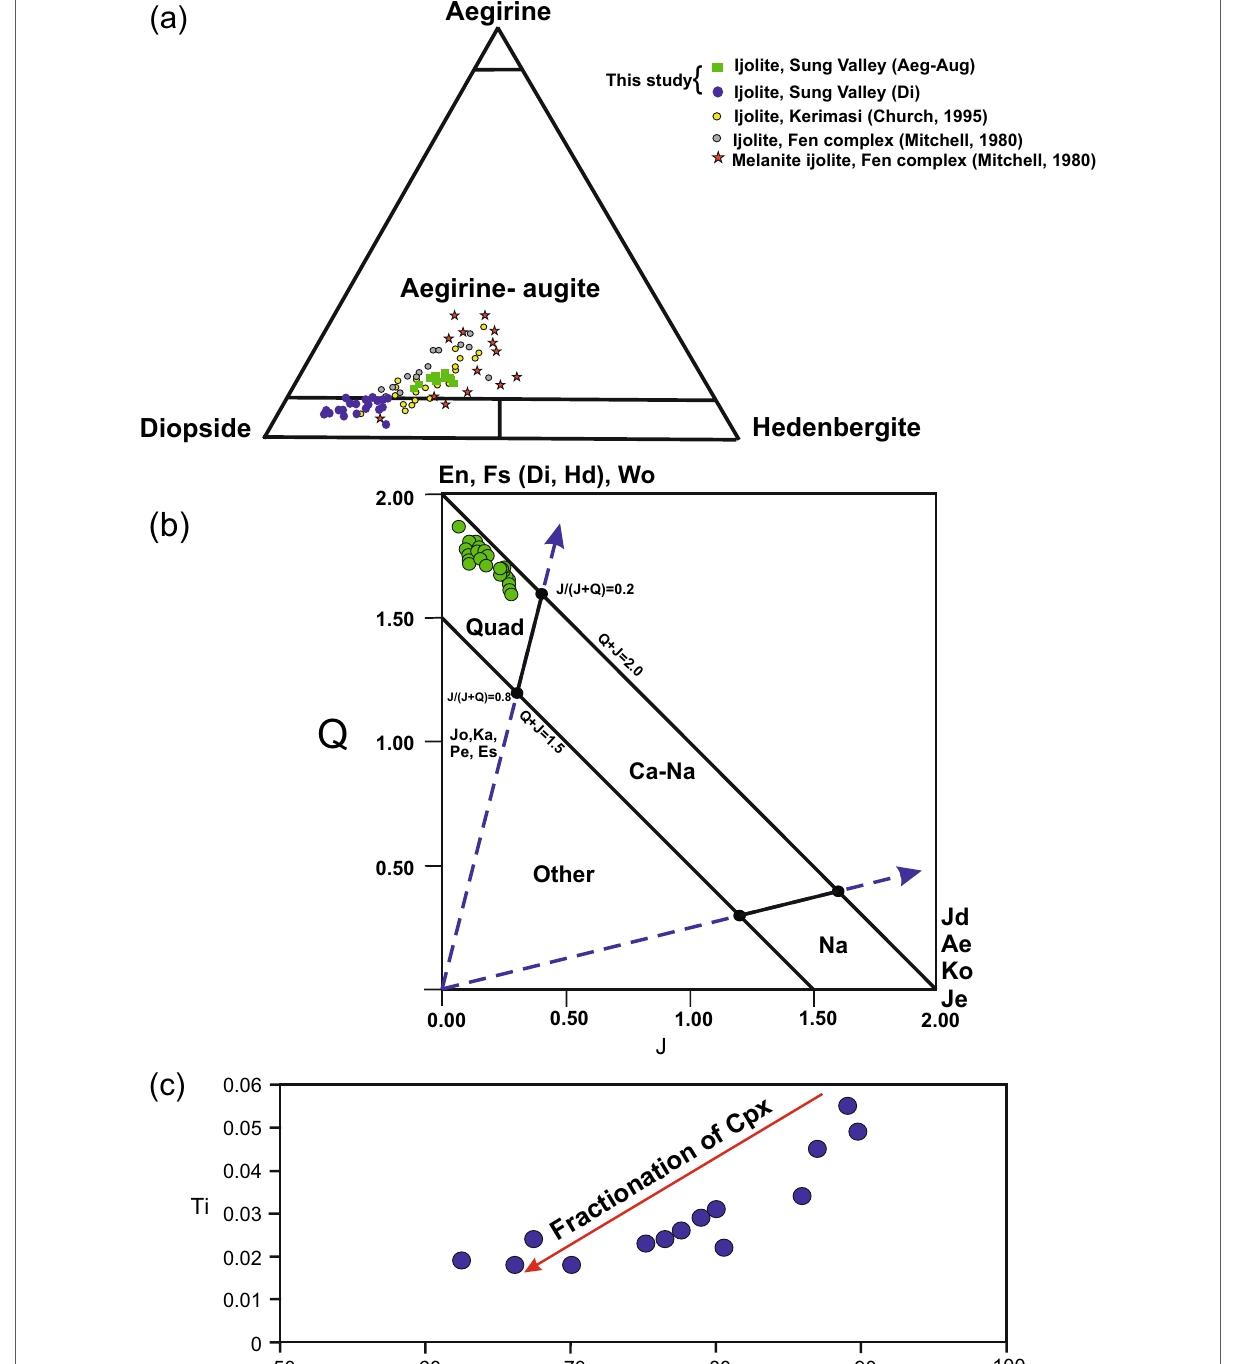
Fig. 3 Plots related to the chemistry of clinopyroxene crystals in Sung Valley ijolites. a Triangular Na-Mg-Fe classification diagram showing that all points of mineral chemistry of clinopyroxene fall in the area diopside and aegirine-augite. This figure also shows the comparison of clinopyroxene from ijolites in Sung Valley UACC with clinopyroxene from Kerimasi and Fen complex ijolites. b Q–J classification diagram for the pyroxenes (Morimoto et al., 1988) showing that all the points of clinopyroxene (aegirine-augite and diopside) composition fall into the Quad field. c Scatter plot between Mg# and Ti in Clinopyroxene showing the depletion of Ti along the line of fractionation of